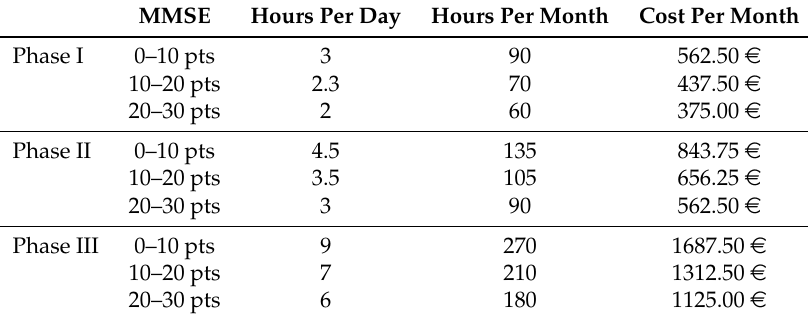
Table 4. Complex care and rehabilitation costs